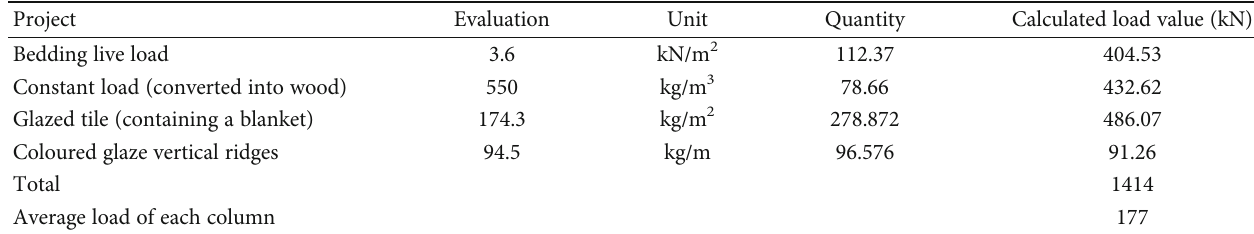
Table 2: Wansui Building load statistic